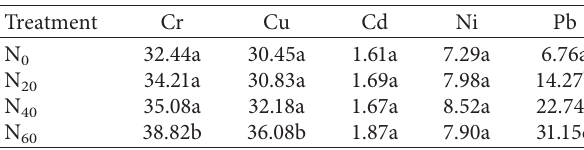
Table 2: Cumulative release amounts of HMs in the soil of WFLZ in the TGR area (unit: µ g).